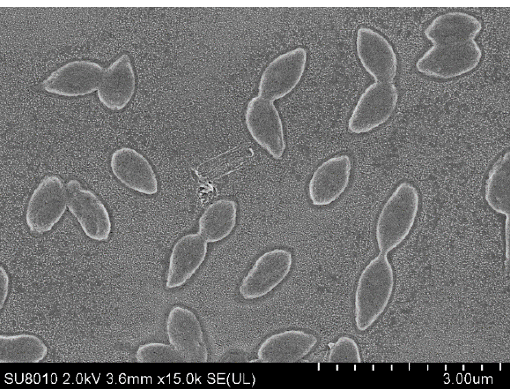
Figure 5. Scanning electron microscopy image showing the cell morphology of strain M6 T .